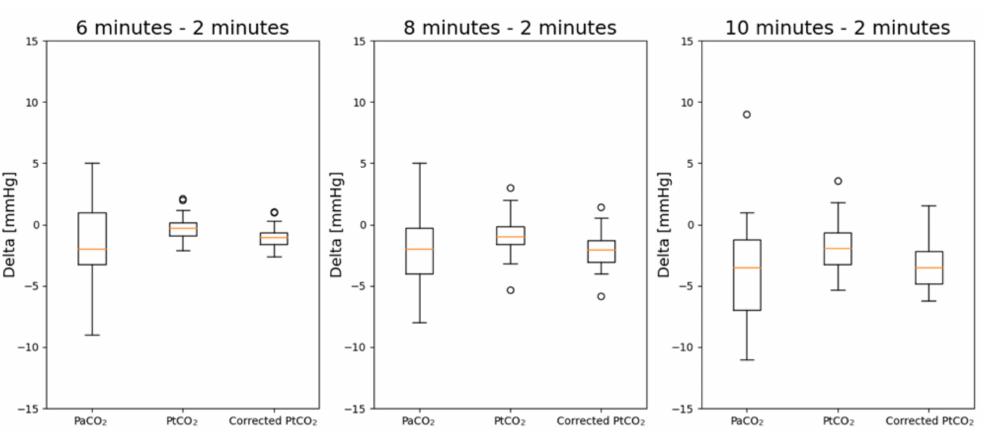
Figure 6. Boxplots of the deltas of PaCO 2 , PtCO 2 and corrected PtCO 2 . The deltas are evaluated at 6, 8 and 10 min with respect to the values measured after 2